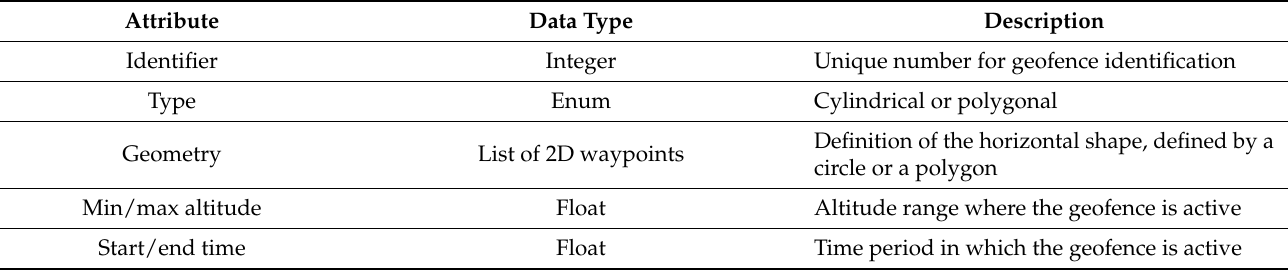
Table 2. Attributes of a geofence